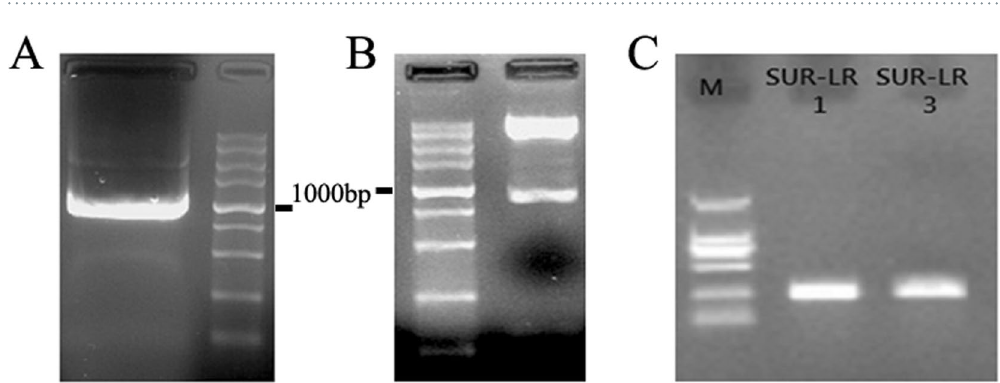
Figure 2. ( A ) The PCR products for PTEN were visualized under a UV transilluminator. The molecule weight (MW) was correct for PTEN (1212 bp). ( B ) The construction of pcDNA3.1-PTEN was proved correct by enzyme digestion. ( C ) Two constructs of survivin (389 bp) shRNA was verified by PCR from engineering bacteria. The DNA marker was DL5000 from Takara